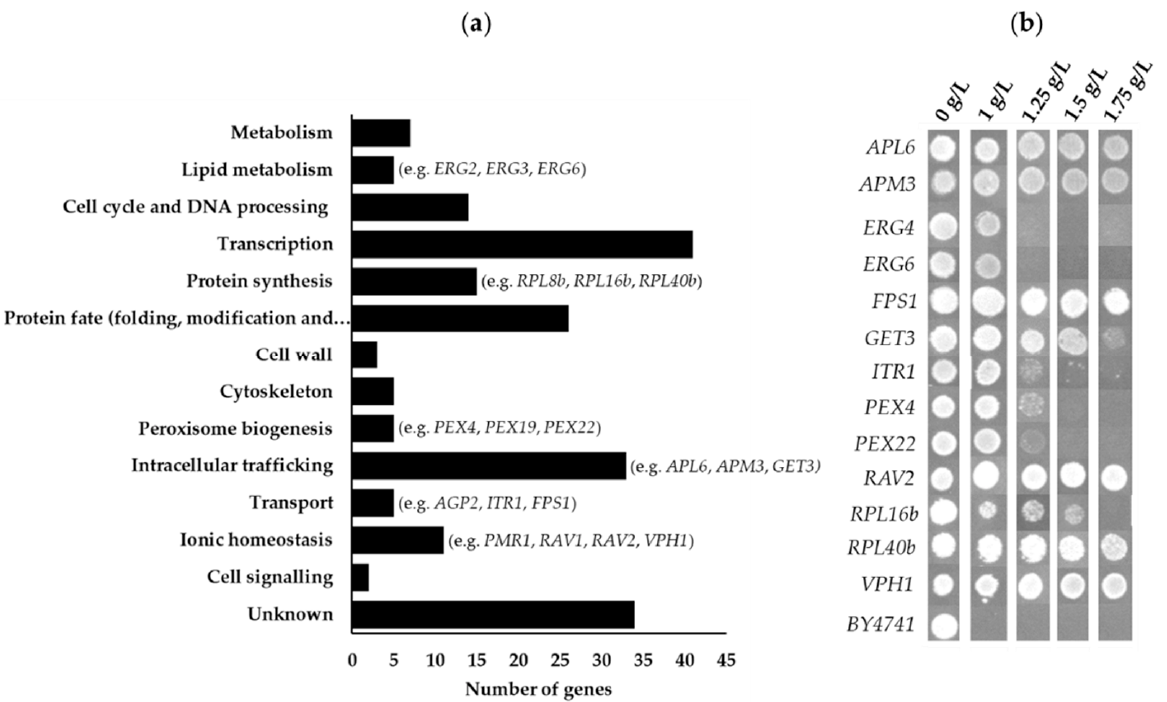
Figure 5. Functional distribution of genes whose deletion increases tolerance to chitosan ( a ). Genes were clustered using MIPS and SGD databases; ( b ) validation of “chitosan-resistance” phenotypes by spot assay on solid MB medium (at pH 3.5) supplemented with 1, 1.25, 1.5 and 1.75 g/L of chitosan No Brett Inside ® .